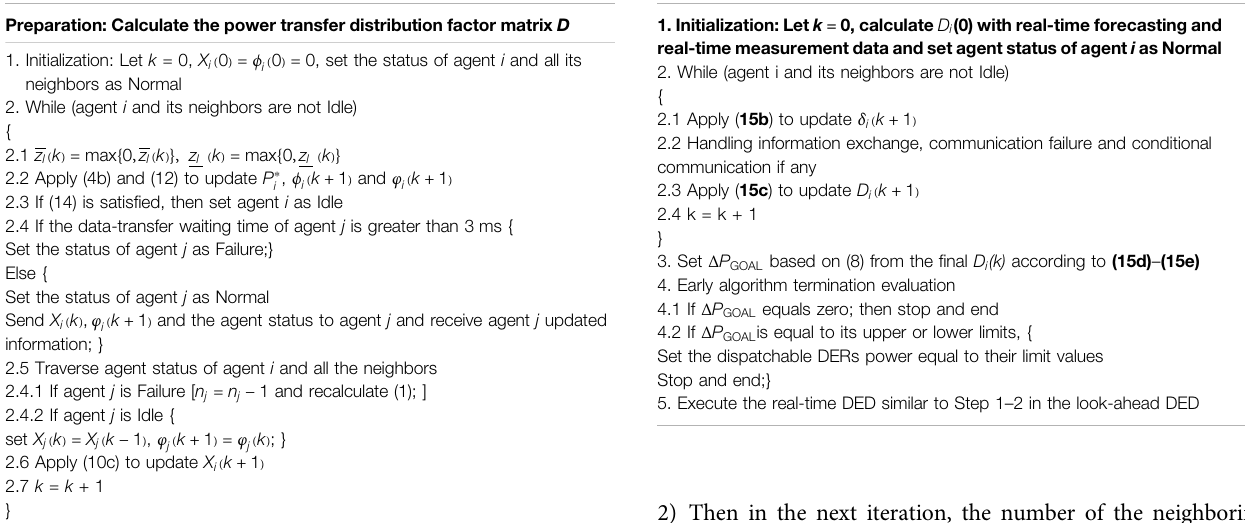
TABLE 2 | Pseudo-code of the real-time